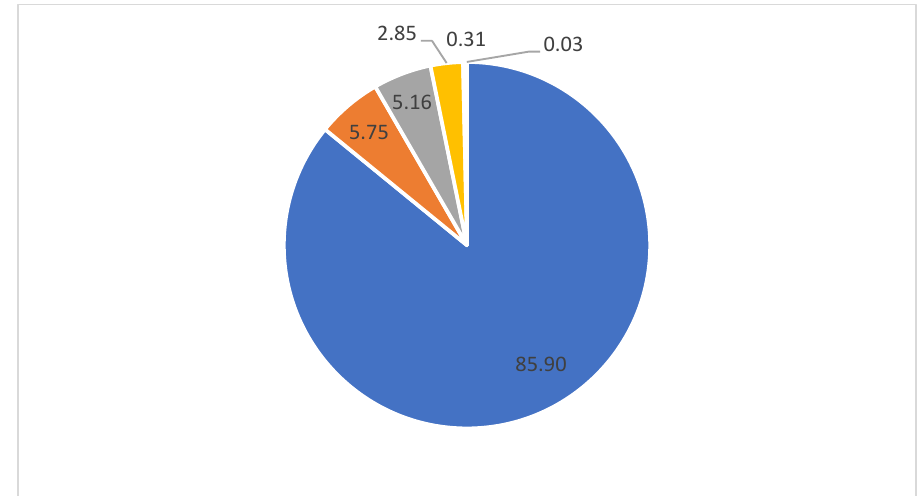
Figure 2. Source type.